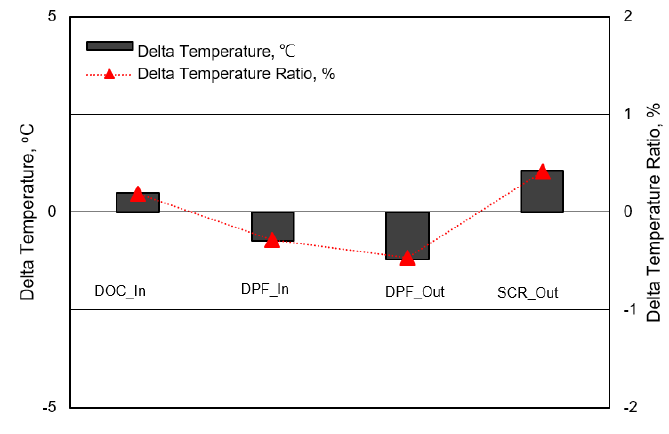
Figure 1. Exhaust gas temperature variation.